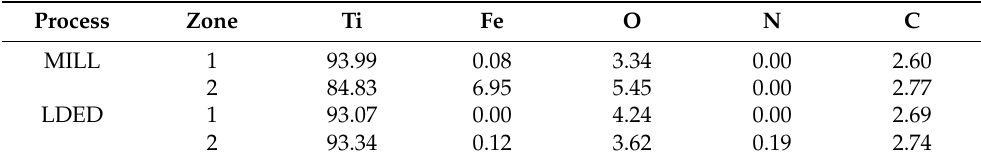
Figure 4. SEM micrographs ( a1,a2,b1,b2 ) and EDS mapping for Ti ( a3,b3 ) and Fe ( a4,b4 ) for MILL ( a1–a4 ) and LDED ( b1–b4 ) materials.